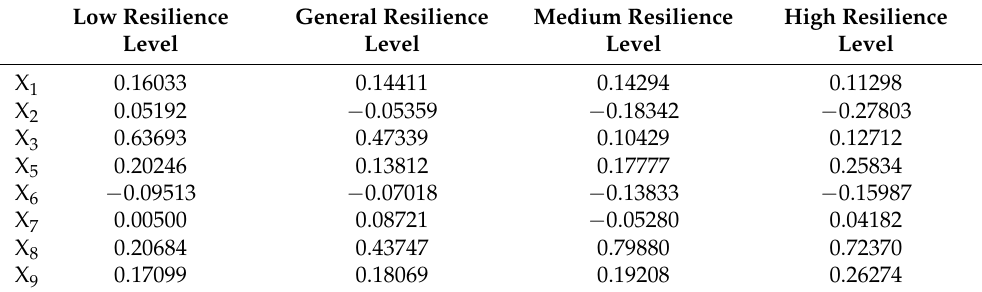
Figure 5. Spatial distribution of the mean value of regression coefficients of influencing factors from 2005 to 2019. ( a ) Emergency facility level. ( b ) Industrial structure. ( c ) Urbanization level. ( d ) Marketization level. Table 6. Mean Values of Regression Coefficients of Influencing Factors for Different Resilience Levels. Low